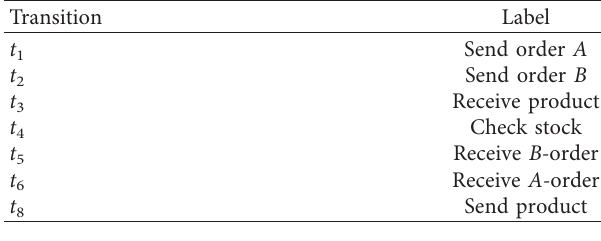
1 corresponding to Reta . (b) Open net N 2 corresponding to Supp .